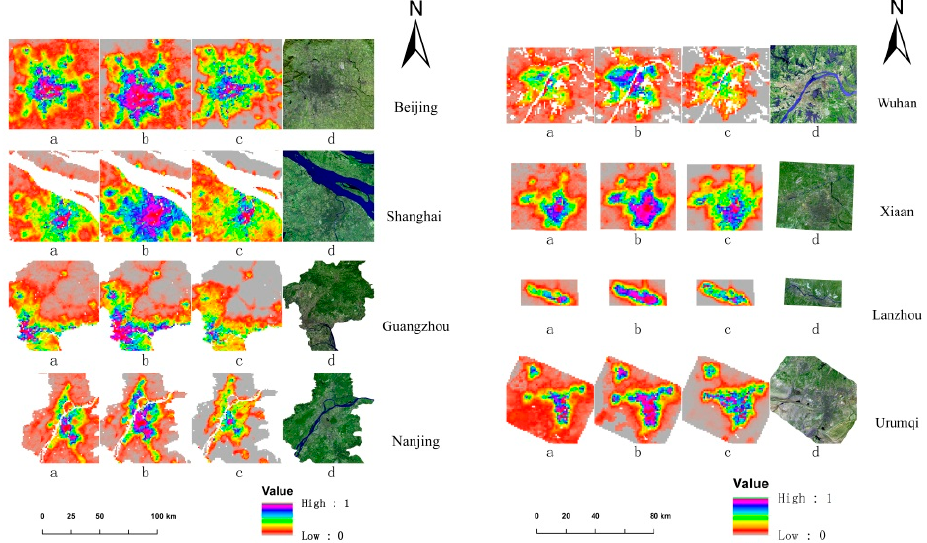
Figure 3. Comparative analysis of the extraction results of the three indexes and the Landsat-8 image baseline data in eight representative cities (Beijing, Shanghai, Guangdong, Nanjing, Wuhan, Xian, Lanzhou, and Urumqi.). Urban impervious surface and distribution map extracted using ( a ) Human Settlements Index (HIS), ( b ) Vegetation-Adjusted NTL Urban Index (VANUI), and ( c ) the EVI-adjusted NTL index (EANTLI) index; ( d ) 7-, 6-, and 4-band combinations of Landsat-8 images for city and building